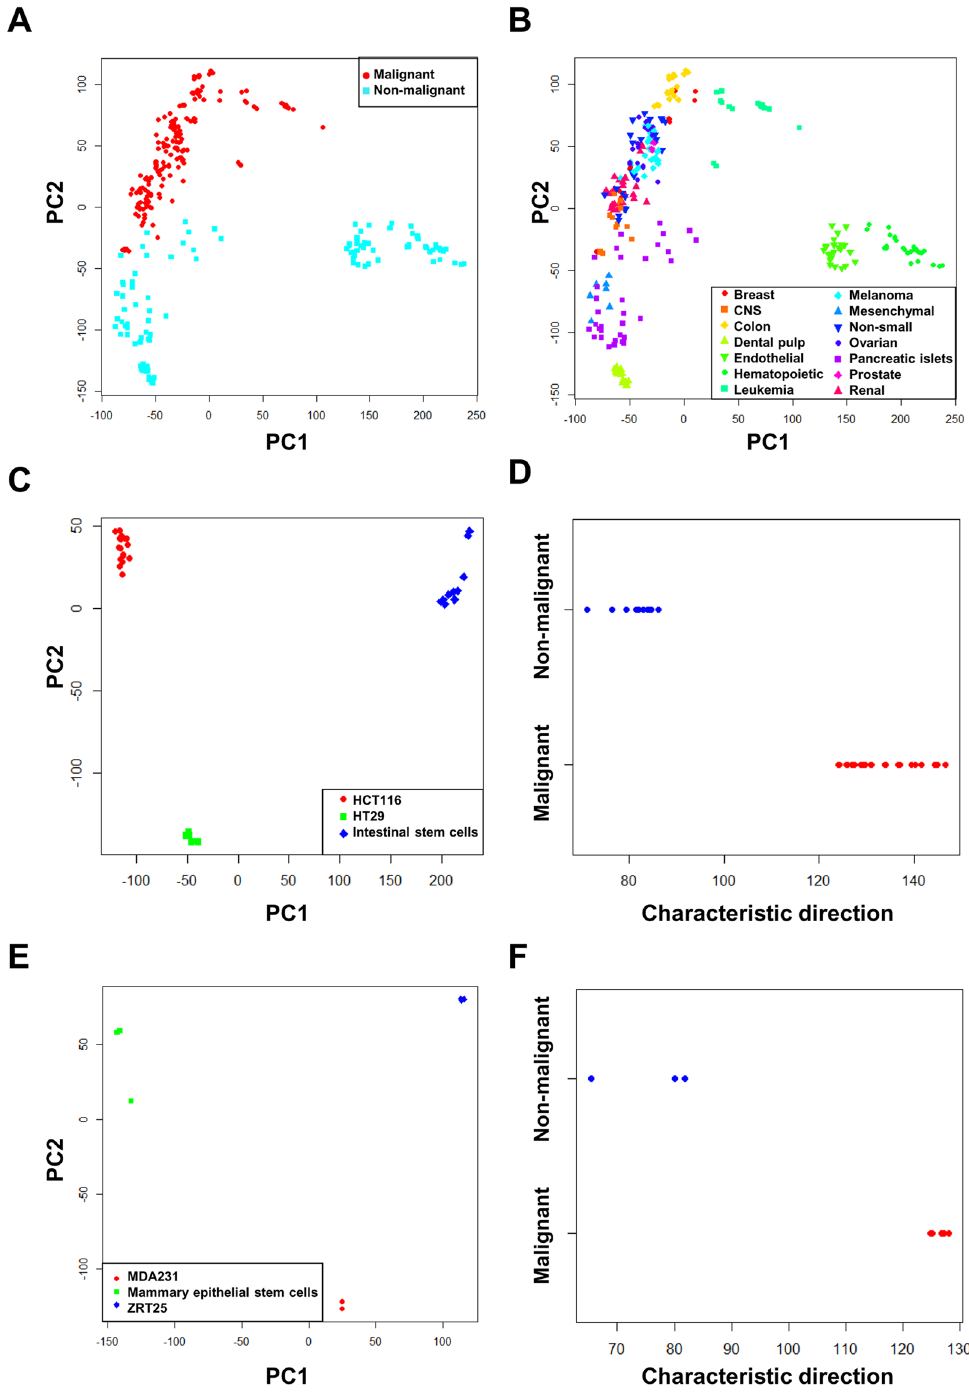
Figure 1. Exploratory analysis of gene expression profiles. The second principal component appears to separate CICs from healthy dividing cells ( A ). The first principal component seems to separate the cells with an origin in the hematopoietic system: hematopoietic stem cells, endothelial progenitor cells, and leukemia ( B ). The colon cancer cell lines HCT116 and HT29 differ strongly between each other and with respect to intestinal stem cells ( C ); however, the projection of their expression profiles along the characteristic direction clusters both cancer cell lines together and separates them from the stem cells ( D ). The same is observed for the breast cancer cell lines MDA231 and ZRT75 ( E ) when compared to mammary epithelial stem cells ( F